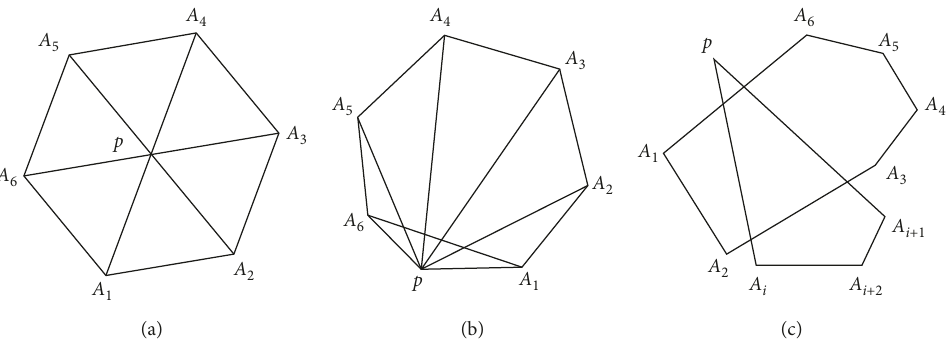
Figure 3: The relationship between a point p and a polygon. (a) Inside the polygon. (b) Outside the polygon. (c) Outside the